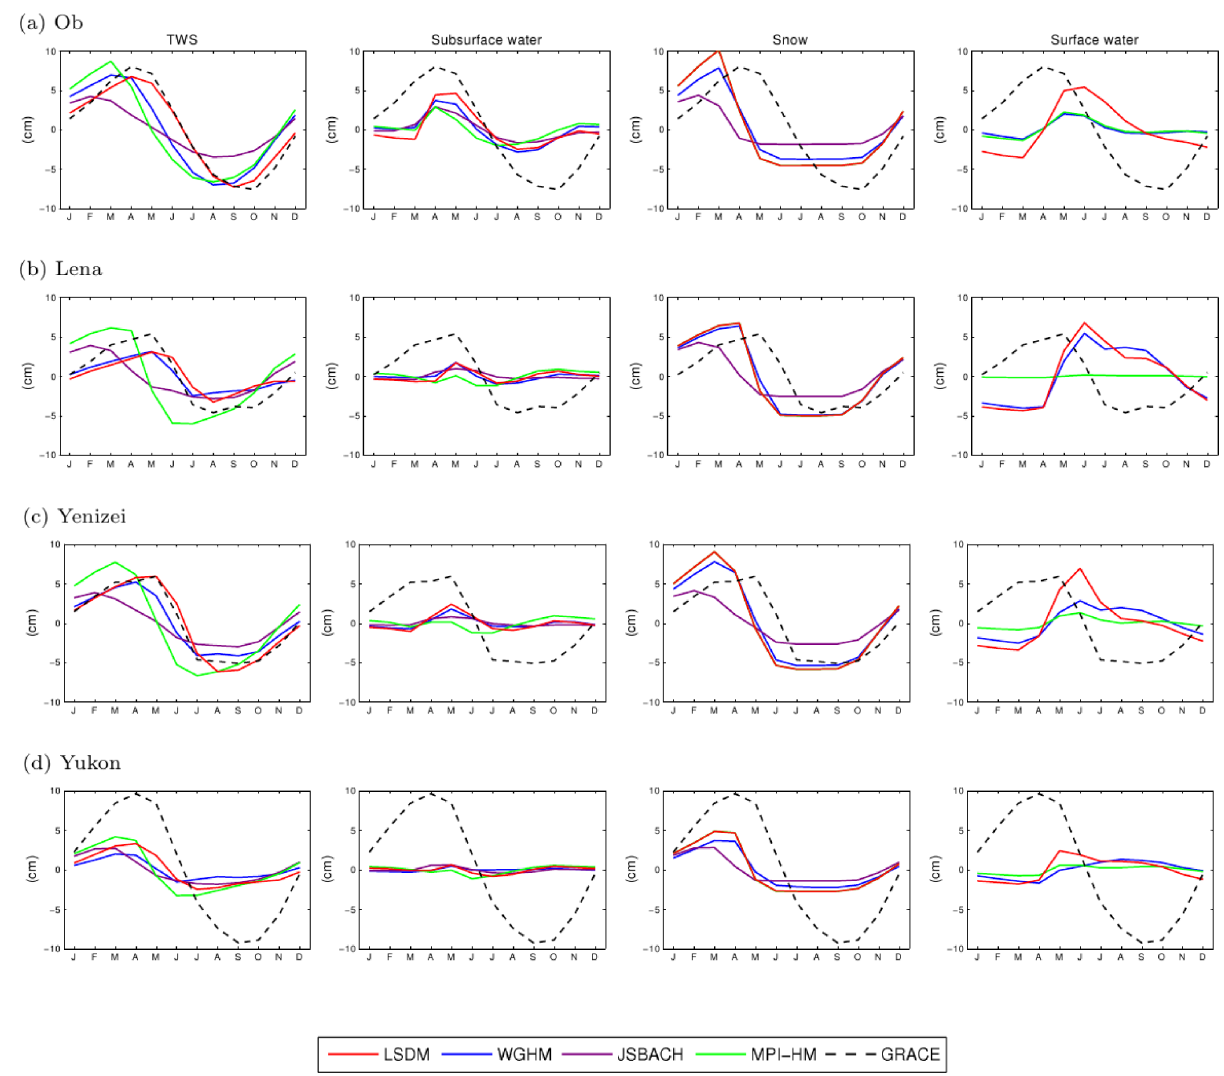
Figure 11. Mean monthly time series of TWS (first column) and the individual storage contributions from subsurface water (second column), snow water equivalent (third column) and surface water (fourth column), each for four snowy catchments: Ob, Lena, Yenizei and Yukon. TWS from GRACE (dashed line) has been included in every sub-figure for